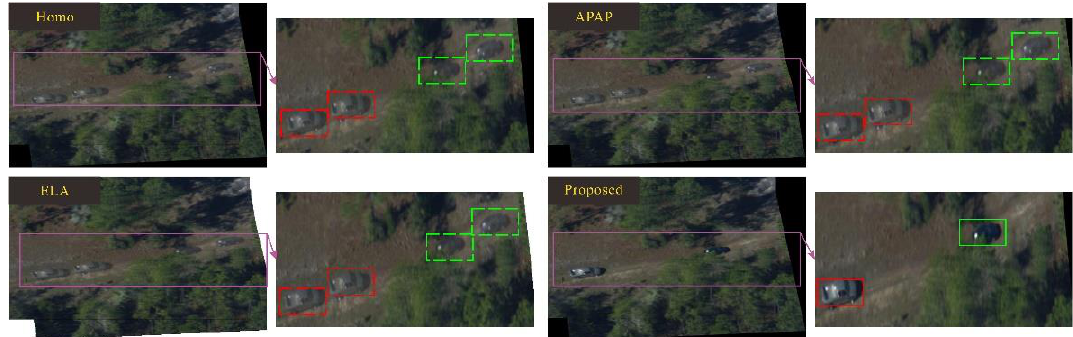
Figure 13. Comparison between the proposed method and SOTA method on eg01 data.